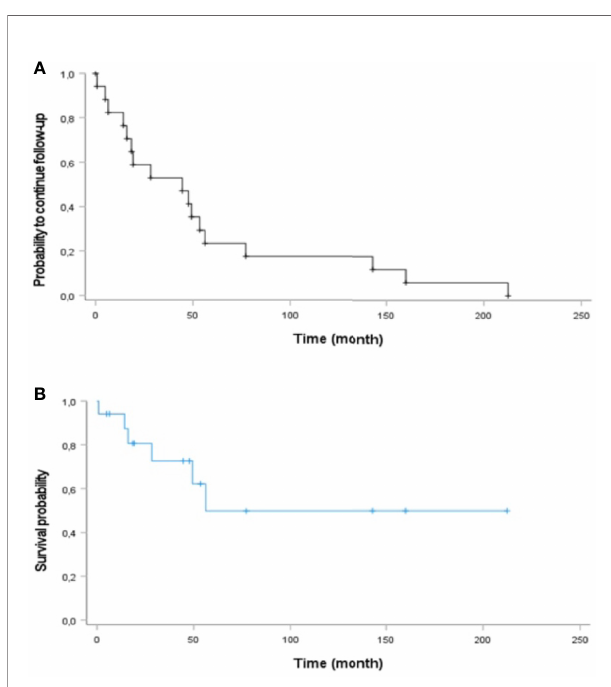
FIGURE 4 | Kaplan – Meier curve analysis of (A) duration of observation and (B) overall survival of patients with primary presacral NEN (n =